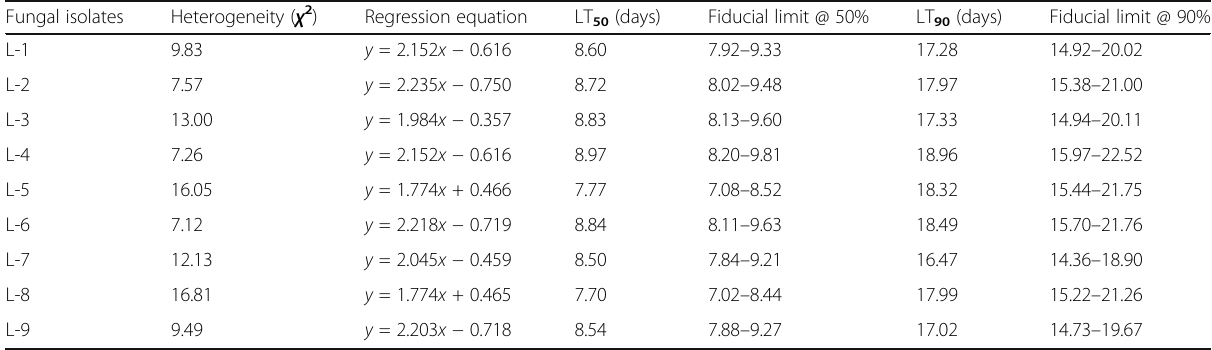
Table 3 Time mortality response of 3rd instar larvae of Spodoptera litura to different fungal isolates of Lecanicillium lecanii Fungal isolates Heterogeneity ( χ 2 ) Regression